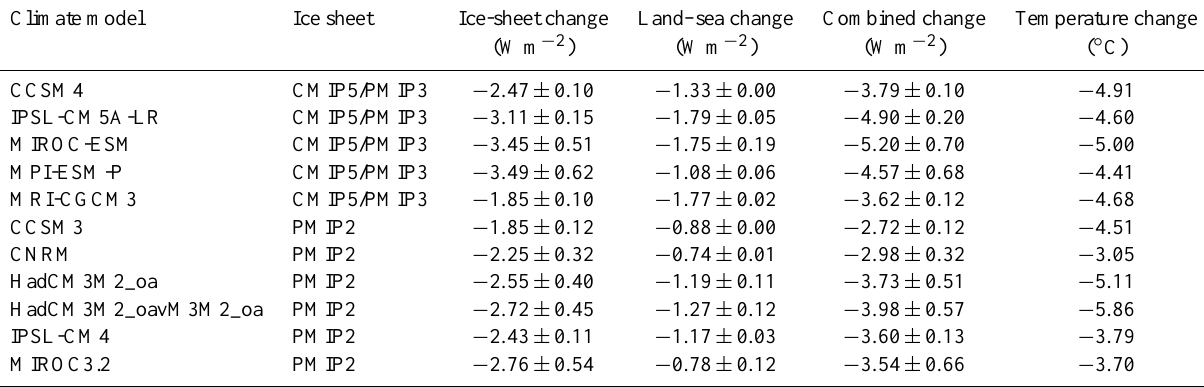
Table 3. Changes in radiative forcing (Wm − 2 ) associated with changes in the ice sheet and implied changes in land–sea geography, calculated for the CMIP5/PMIP3 composite and the PMIP2 ice sheets respectively. The resulting change in global annual mean surface air temperature ( ◦ C) is shown in the last column. The error is calculated as the difference between the estimates obtained while using the present-day climate as a reference or the glacial climate as a reference in the partial-radiative perturbation calculation. Note that the values given for the PMIP2 ice sheet are slightly different from those given in Braconnot et al. (2012) because of corrections made subsequent to the publication of that paper. Values given here may also differ slightly from published results of individual models where either a different method or a different time window was used for the